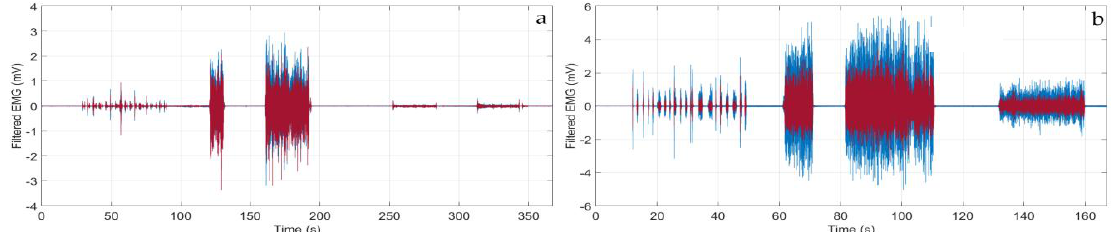
Figure 7. Filtered sEMG traces recorded with the wearable device (red line) and the Digitimer D360 equipment (blue line) in the case of: ( a ) brachial biceps contraction; ( b ) abductor pollicis brevis